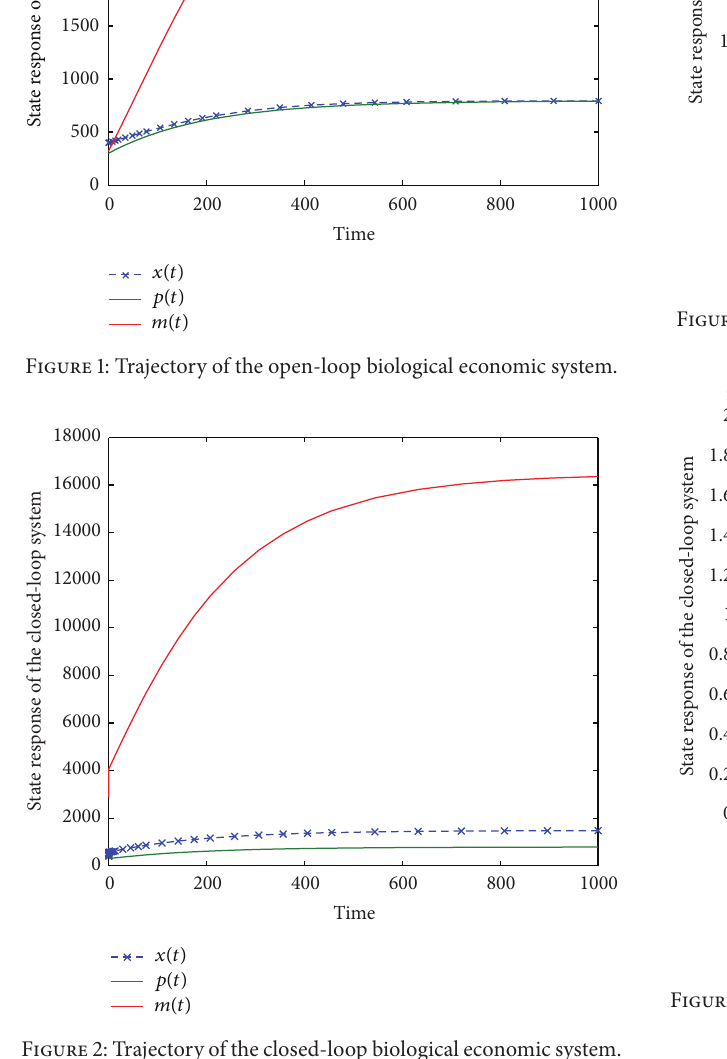
Figure 2: Trajectory of the closed-loop biological economic system.